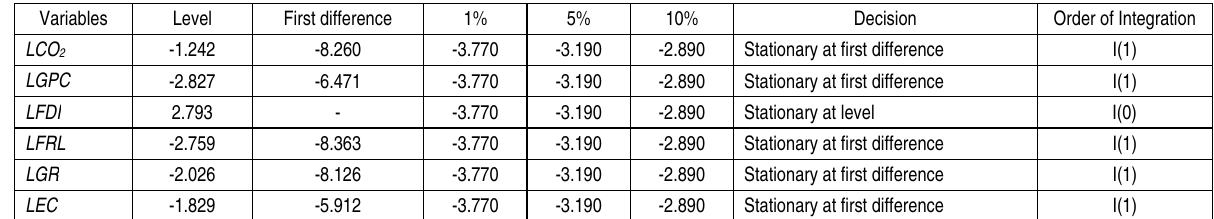
Table 2. Dicky-Fuller-GLS unit root test (1972-2013)